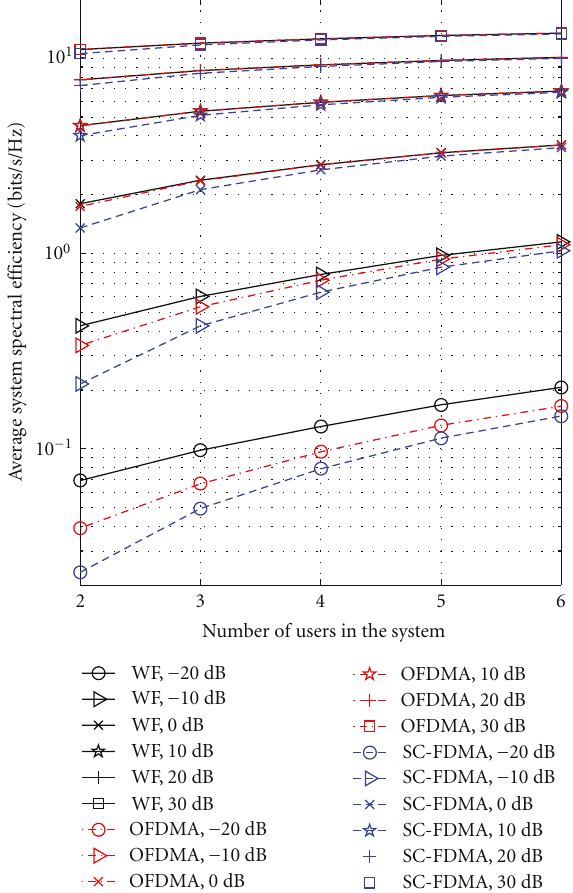
Figure 5: Comparison of the achievable system information rate between OFDMA and SC-FDMA for di ff erent numbers of users under di ff erent receive SNR conditions in SCME “urban-macro”